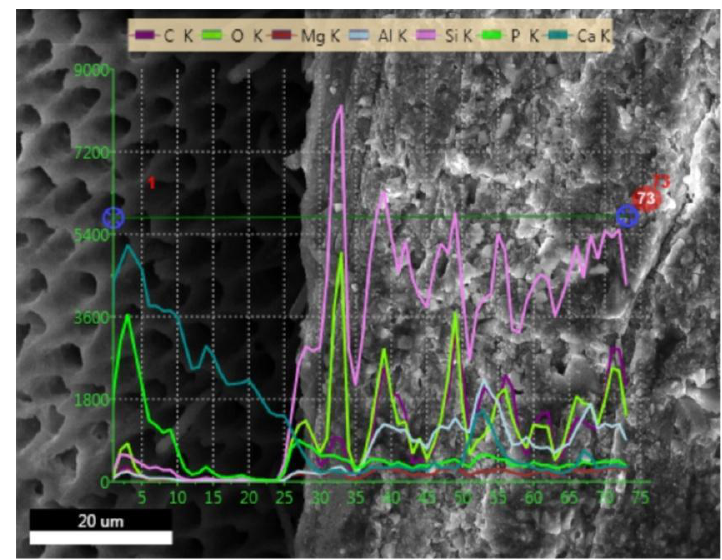
Figure 5. EDS line scan signals of individual elements present at dentin-resin interface obtained for Adper Easy One applied twice in 40 s (group 2A40).